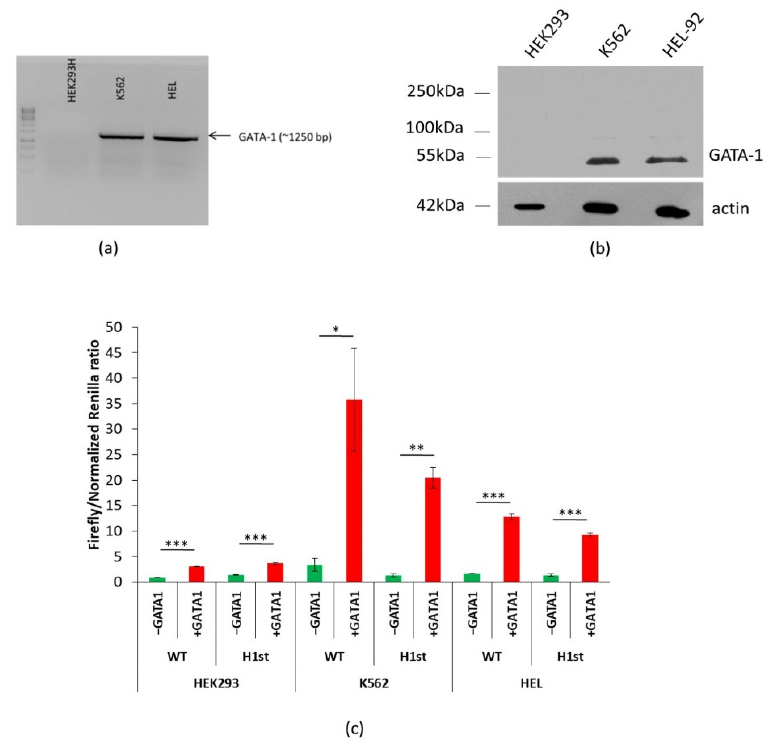
Figure 3. Potential role of GATA1 in the regulation of PMCA4b expression. For details, see Section 2. ( a ) GATA1 mRNA expression in HEK, K562 and HEL cells. ( b ) GATA1 protein expression HEK, K562 and HEL cells—Western blot of total protein extractions from HEK293, K562 and HEL-92 cells with anti-GATA1 and anti-actin primary, HRP-labeled secondary antibodies. ( c ) Dual-luciferase assay in the GATA1-expressing, transfected cells. The inserted WT or the minor haplotype (H1) versions of the ATP2B4 regions were expressed in HEK, K562 and HEL cells along with pIRES2-GATA1 or pIRES2 empty vector. Normalization of the Renilla luciferase activity in the case of GATA1 overexpression was used, see details in Supplementary Table S1. The ratio of the Firefly/normalized Renilla luciferase activity is shown ( n = 4, unpaired two-tailed t-test: * p < 0.05, ** p < 0.01, *** p < 0.001).